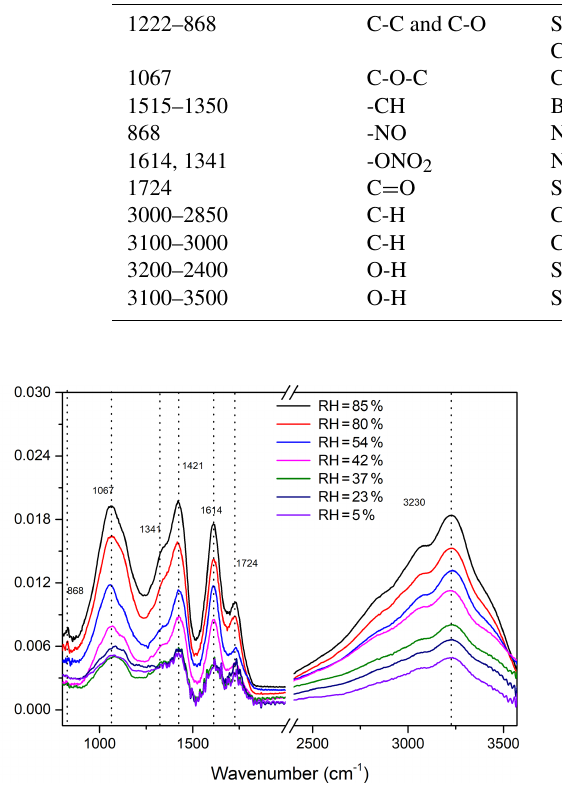
Figure 6. FTIR spectra of particles collected from furan–NO x – NaCl photooxidation experiments with different values of RH, rang- ing from 5% to